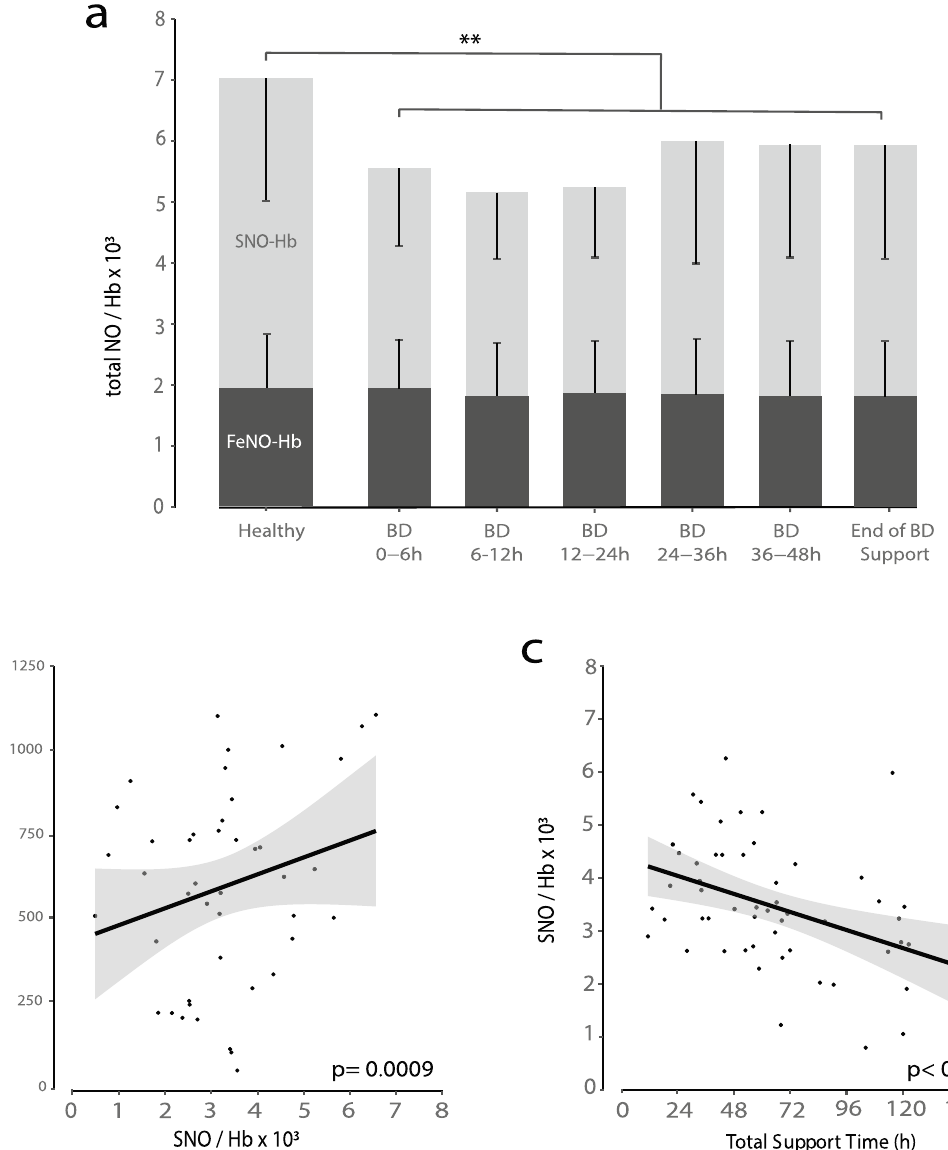
n = 10 healthy volunteers (p = 0.003). ( b ) Association between tissue oxygen saturation (StO 2 ) (Area under the curve over minutes) and SNO-Hb concentration. ( c ) Association between SNO-Hb concentration and total support time (in